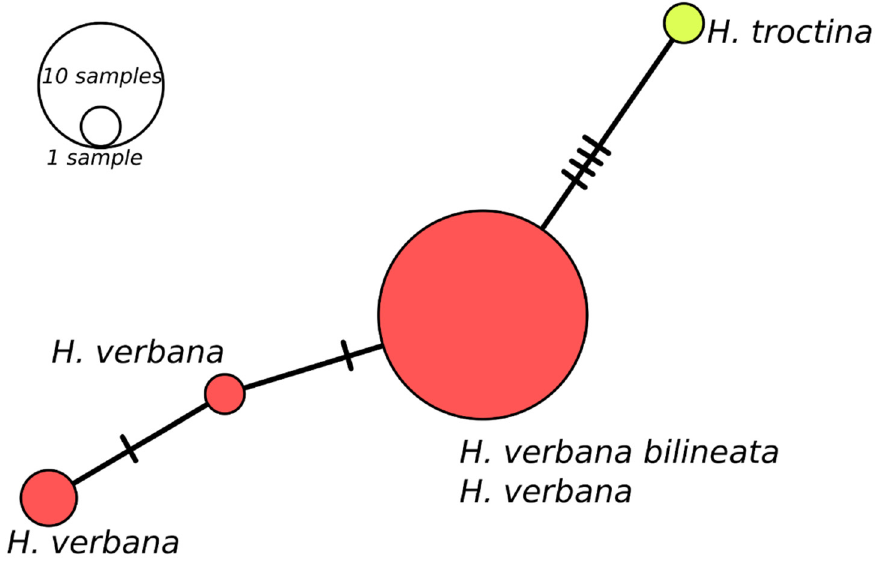
Figure 7. Minimum spanning network of Hirudo verbana and Hirudo troctina ITS2 haplotypes. The bars on branch length represent the number of substitutions.